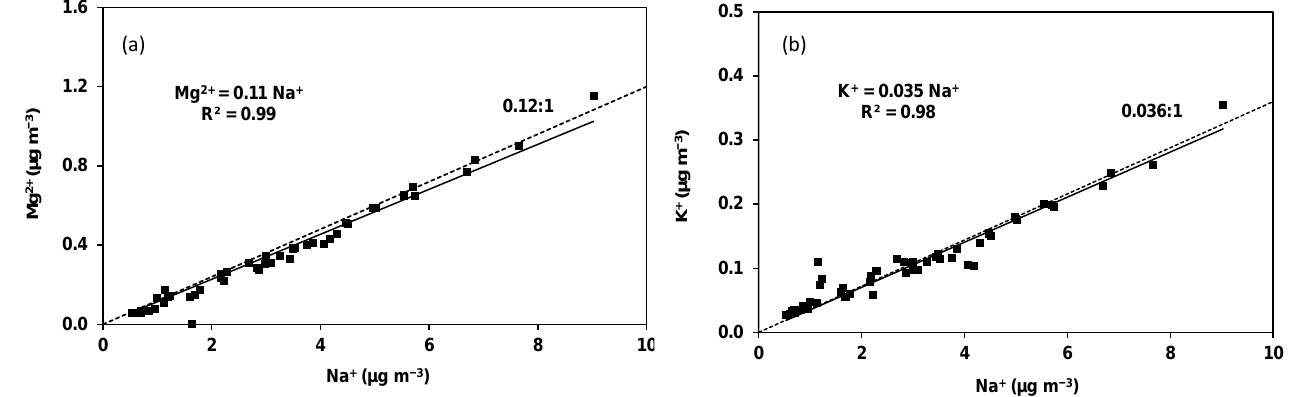
Figure 5. Correlations between: ( a ) Mg 2+ and Na + , ( b ) K + and Na + . The dashed lines indicate ion ratios in fresh seawater.